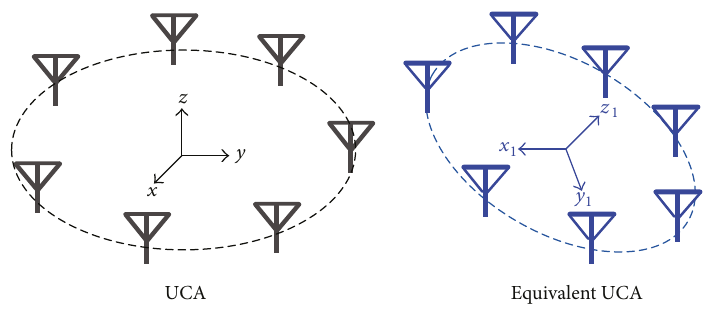
Figure 2: UCA and the equivalent